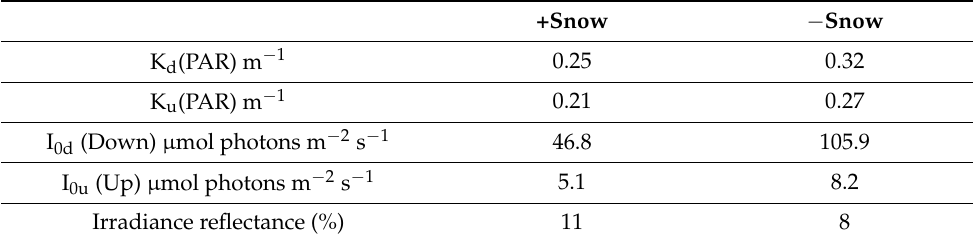
Table 2. Partitioning (%) of K d (PAR) relative to the optical constituents-water, CDOM, phytoplank- ton, and suspended particulate matter.